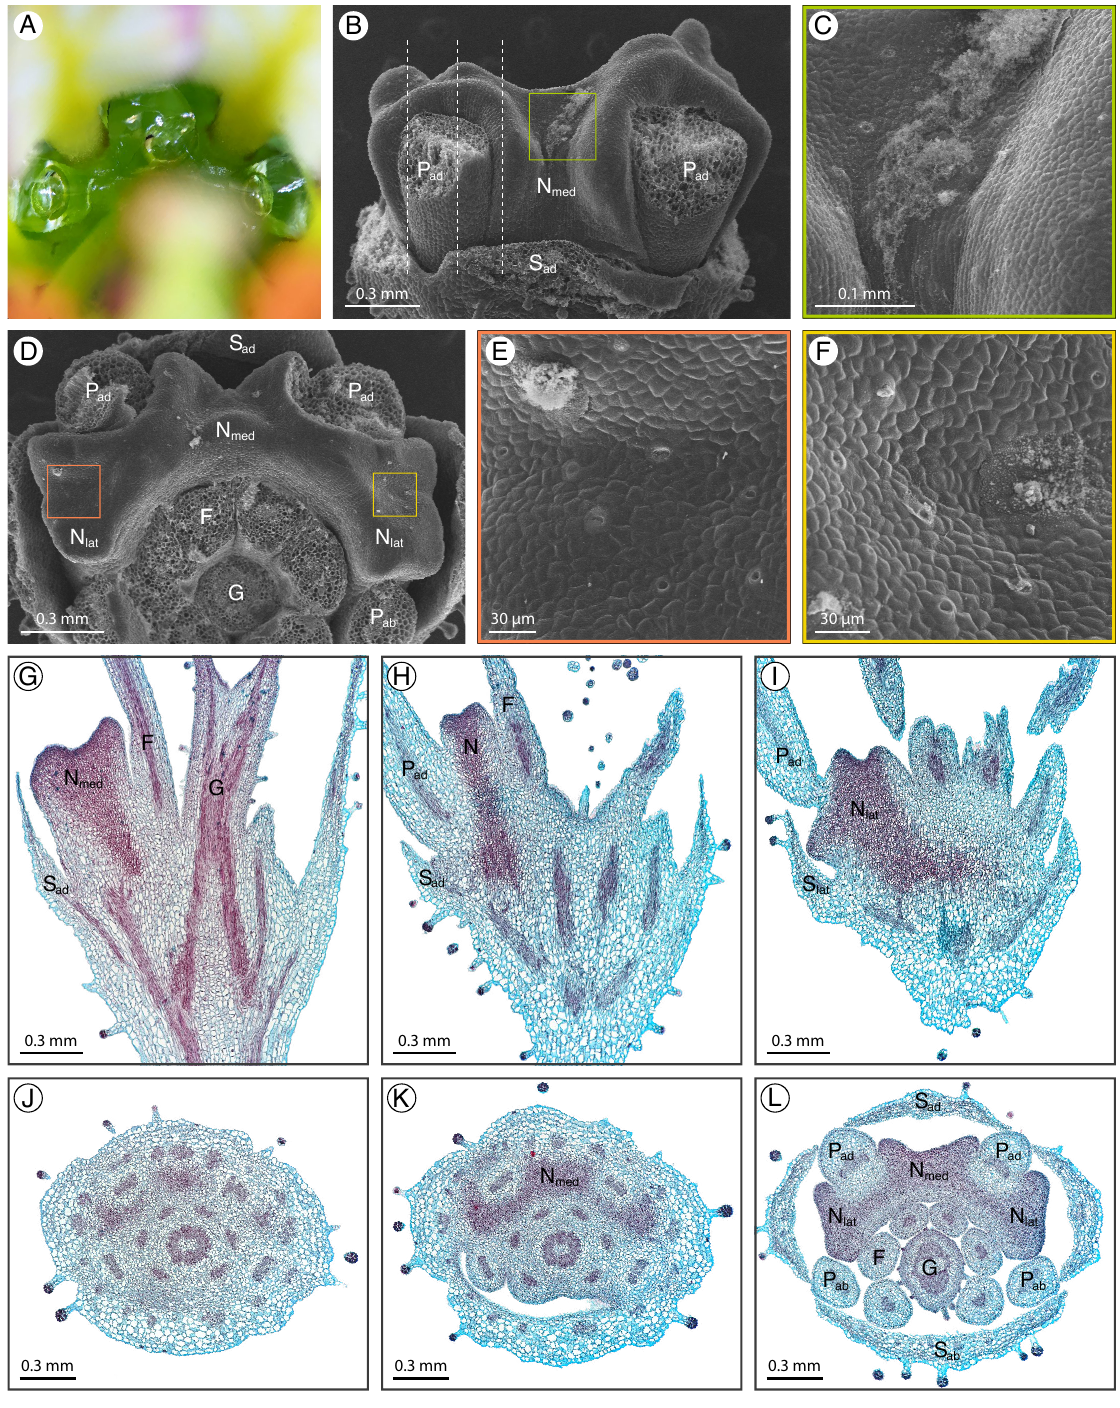
Figure 3. Cleome amblyocarpa nectary ( A ) photograph, ( B – F ) scanning electron micrographs, and ( G – L ) fast green and safranin O-stained sections. ( A ) Apical view of the nectary. ( B ) Adaxial view of the nectary. ( C ) Adaxial view close-up of the medial nectary lobe, corresponding to the box in ( B ). ( D ) Apical view of the nectary. ( E , F ) Apical view close-ups of the lateral nectary lobes, corresponding to the left and right boxes in ( D ), respectively. ( G – I ) Longitudinal sections (sagittal plane) of the nectary, corresponding to the dashed lines in ( B ) from right to left, respectively. ( J – L ) Transverse sections of the intermediate stage nectary from proximal to distal positioning. All images are of anthetic stage specimens unless indicated otherwise. F: filament; G: gynophore; N lat : lateral nectary lobe; N med : medial nectary lobe; P ab : abaxial petal; P ad : adaxial petal; S ab : abaxial sepal; S ad : adaxial